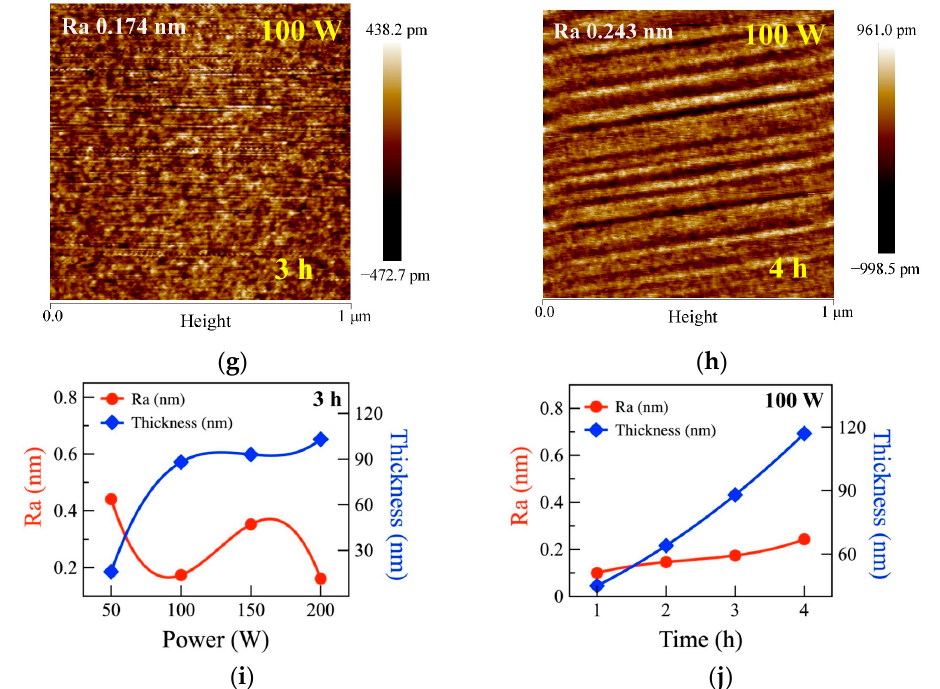
Figure 4. AFM images of TbDyFe thin films under diverse ( a – d ) sputtering powers (50 W, 100 W, 150 W, and 200 W, respectively), ( e – h ) deposition times (1 h, 2 h, 3 h, and 4 h); the dependence of surface roughness R a and film thickness was on ( i ) sputtering power and ( j ) deposition time.